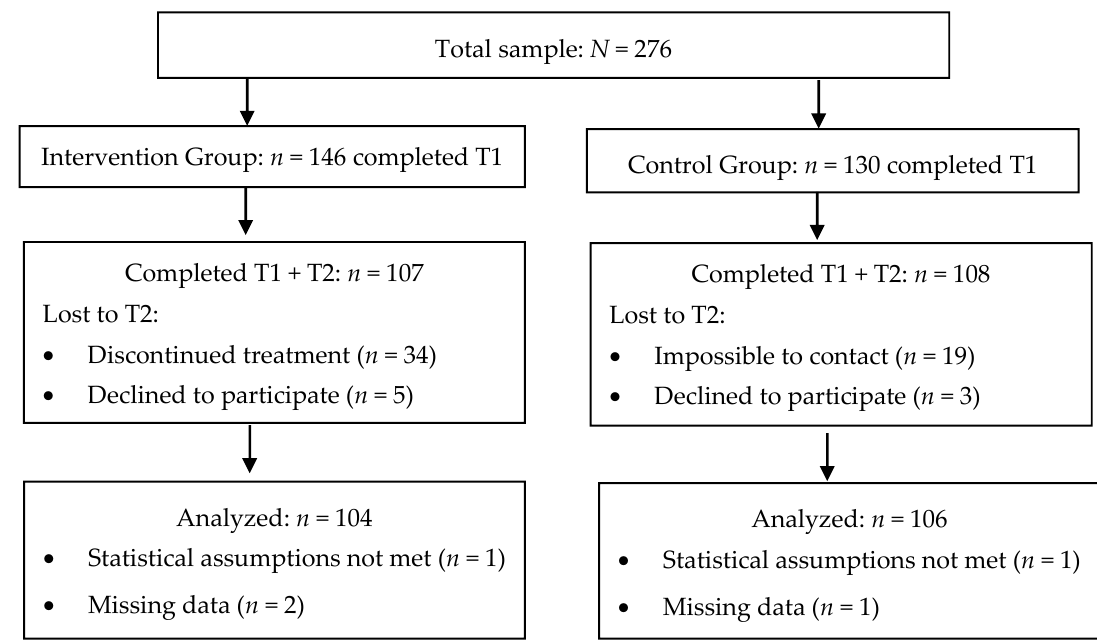
Figure 1. Flowchart of participants throughout the study.